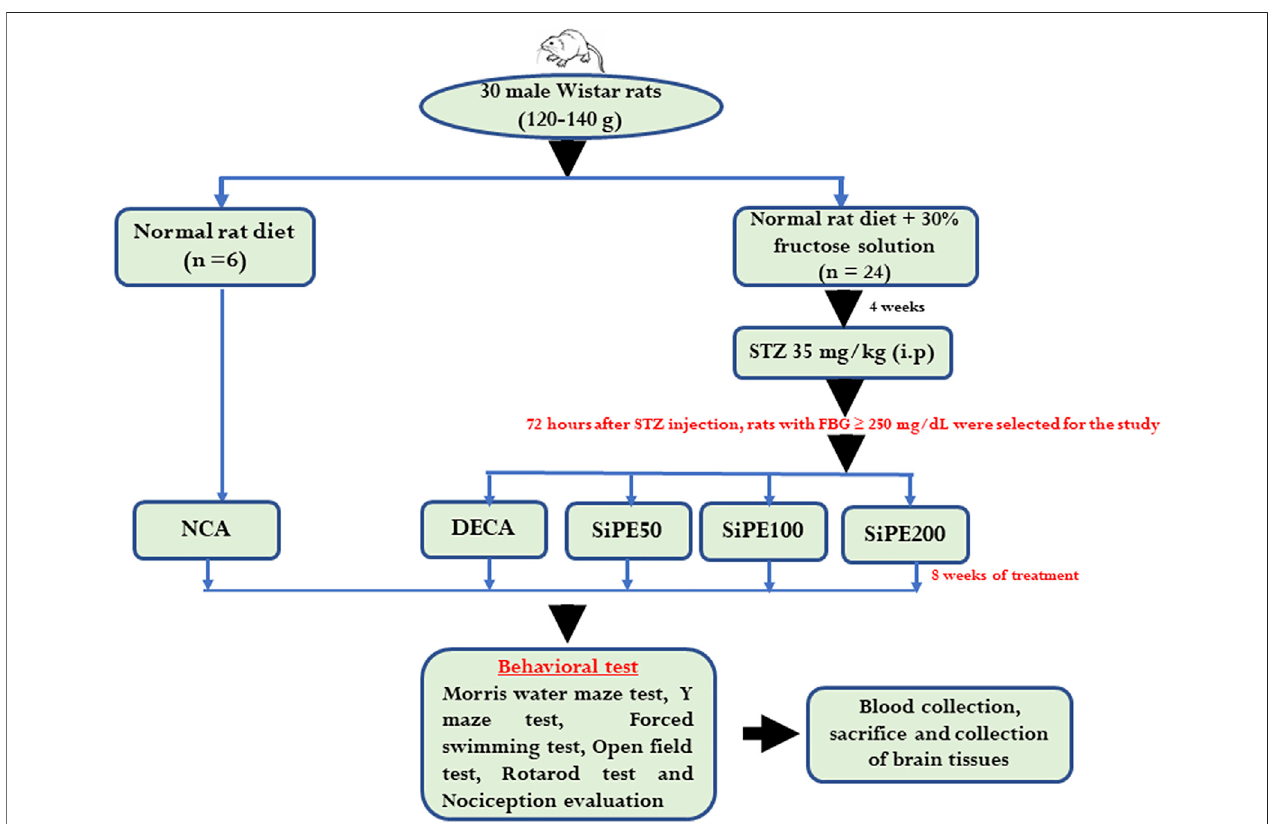
FIGURE 1 | Schematic diagram showing the experimental